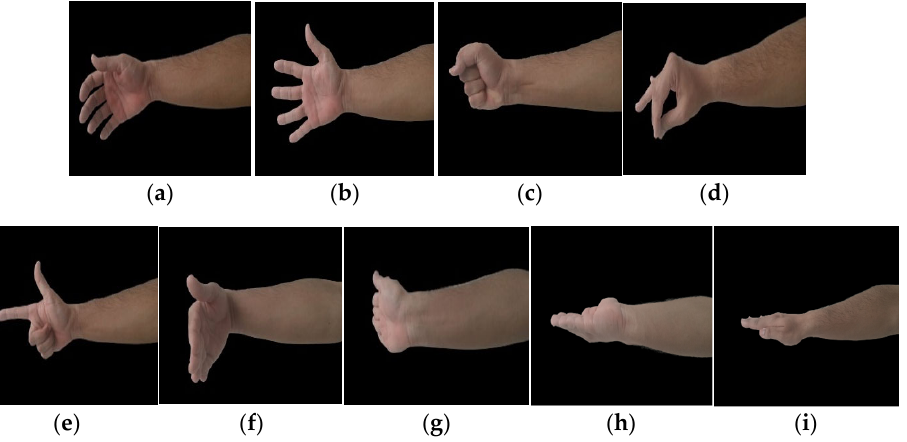
Figure 4. Upper limb gestures: ( a ) Relax, ( b ) fingers extended, ( c ) power, ( d ) tripod, ( e ) finger point, ( f ) wrist flexion, ( g ) wrist extension, ( h ) forearm supination, and ( i ) forearm Pronation.